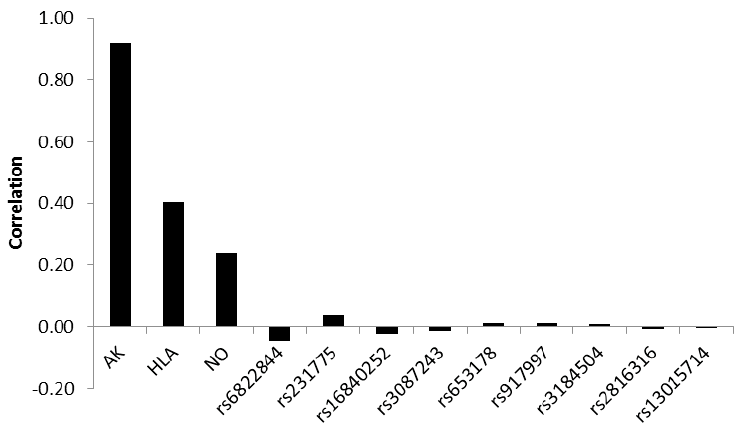
Figure 3. Correlations between the discriminating biopsy score variable and canonical discriminant functions in children with ( n = 109) and without ( n = 68) celiac disease. Ab: antibodies.